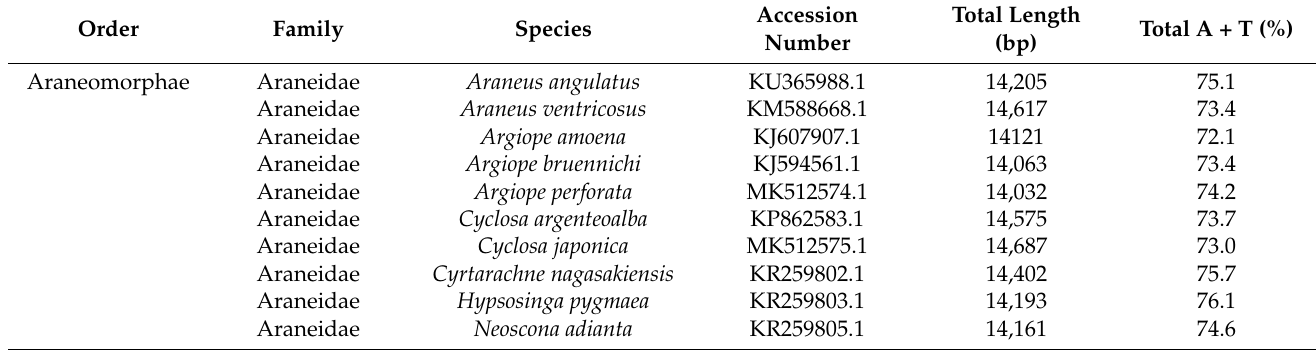
Table 2. Summary of the mitogenomes used in the